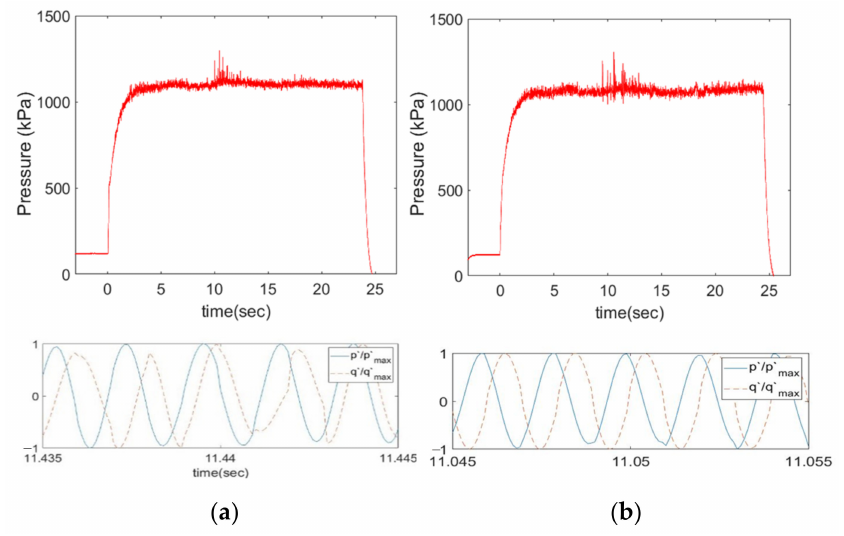
Figure 11. Combustion pressure and coupling status between normalized p (cid:48) and q (cid:48) in ( a ) test 4 (5 ◦ ) and ( b ) test 6 (6 ◦